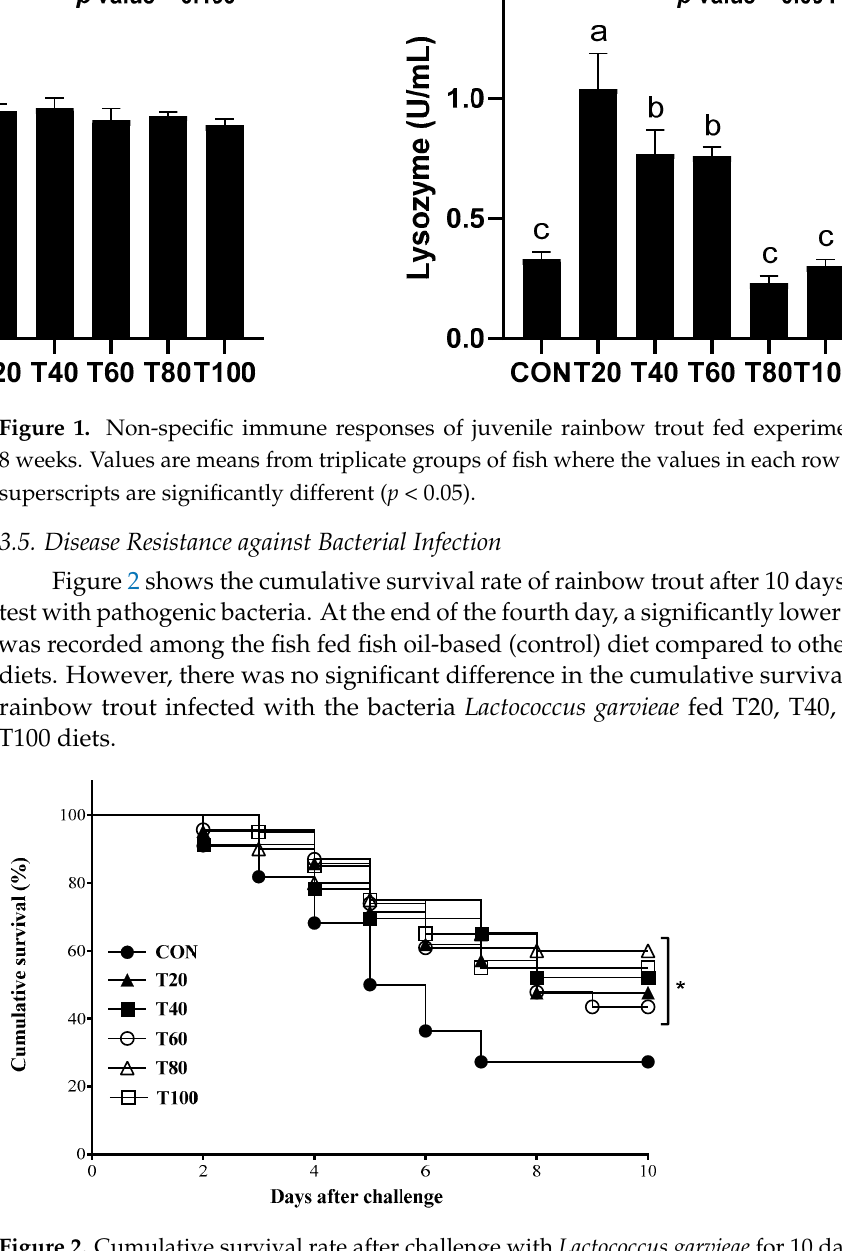
trout fed the experimental diets for 8 weeks. p -value: 0.038. Values are means from triplicate groups